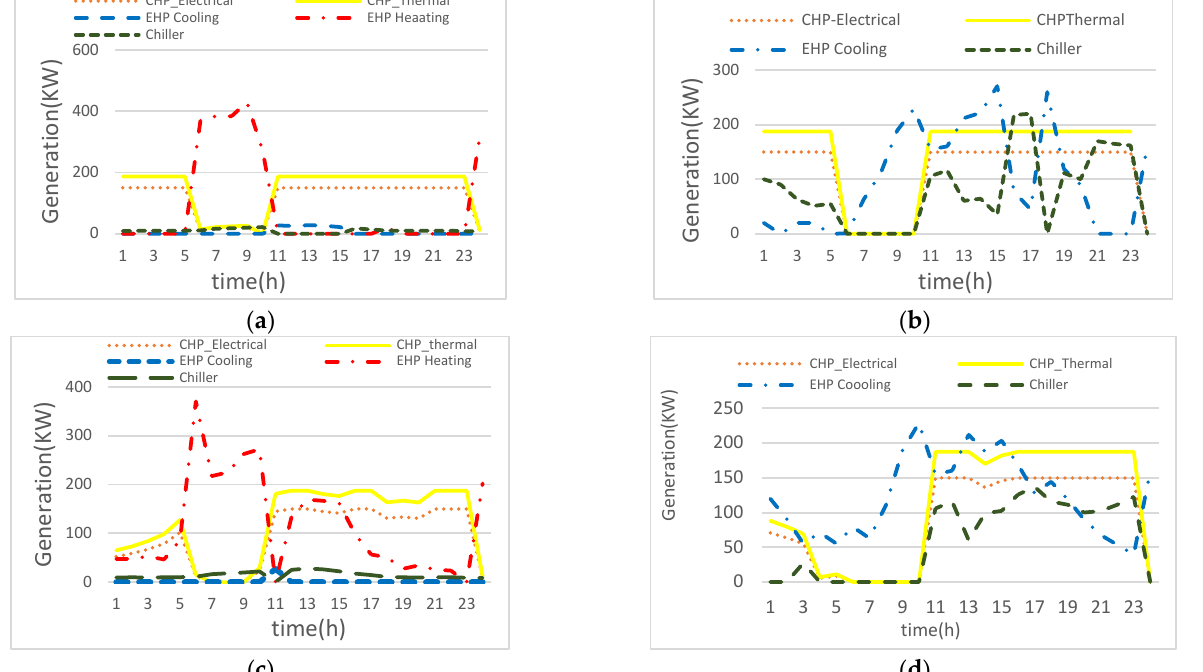
Figure 5. Operation of the main equipment. ( a ) scenario 1 ( b ) scenario 2 ( c ) scenario 3 ( d ) scenario 4.